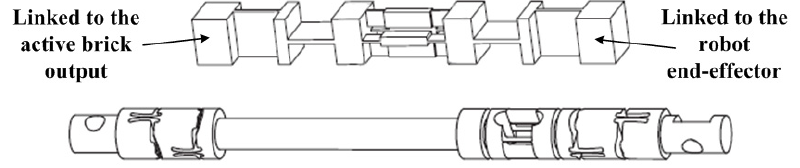
Figure 11. Arms of the Sigma 6 robot (Helmer, 2006), which can be used as passive bricks. They present 5 degrees of freedom; the only blocked motion is the translation along the arm axis.